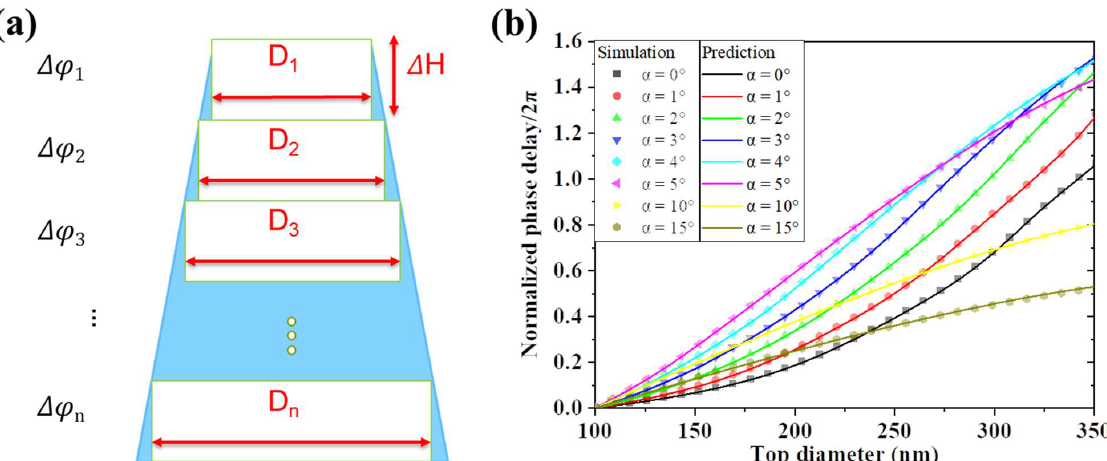
Figure 8. ( a ) The irregular-shaped grating unit is equivalent to a multi-piece structure with a graded gradient index; the truncated cone is divided into ultra-thin cylinders. ( b ) The phase modulation performance of the unit cells. The curves represent our prediction with the MTD method, while the symbols represent our previous simulation.